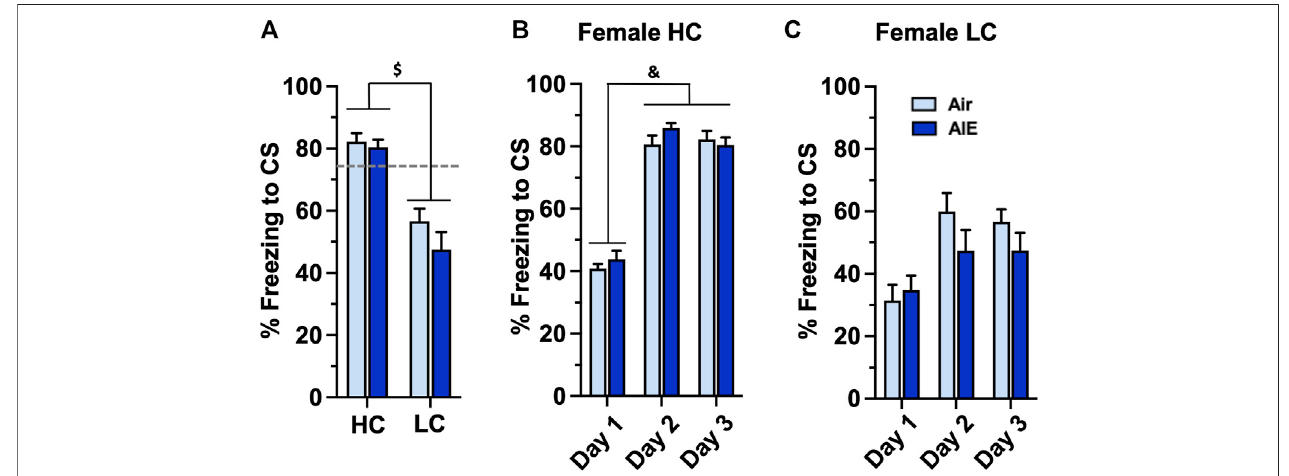
FIGURE 6 | AIE exposure did not alter the acquisition of conditioned fear in either high conditioning (HC) or low conditioning (LC) female rats. Female rats were classi fi edaseitherhighorlowconditioningratsusingacut-offcriteriabasedupontheminimallevelofconditioningexhibitedbymalerats. (A) Comparisonofpercentage offreezingatconditioningday3revealedasigni fi cantdifferenceintheleveloffreezingbetweentheHCandLCgroups.Examinationofthetime-courseoffreezingacross conditioning for the HC (B) and LC (C) female rats revealed that the Air control and AIE exposed rats in each group conditioned at similar rates. $, signi fi cant differencebetweenHCandLCrats(all p values < 0.0001);&,signi fi cantdifferenceofDay1versusDay2andDay3(all p values < 0.0001).AirHC, n =6;AIEHC, n =9;Air LC, n = 12; AIE LC, n = 9.